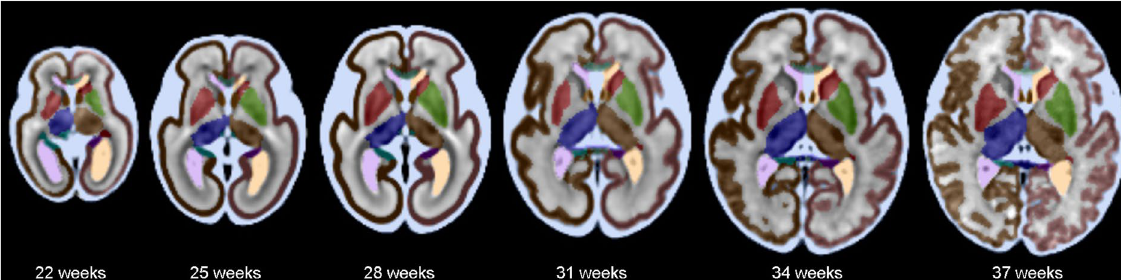
Figure 6. Tissue segmentation and structural labels defined and overlaid on the spatiotemporal fetal brain MRI atlas at six representative GAs: 22, 25, 28, 31, 34, and 37 weeks. The labels visible on these axial sections include the developing white matter, cerebrospinal fluid (CSF), corpus callosum, and left and right gray matter (cortical plate), ventricles, thalami, hippocampi, and lenticular and caudate